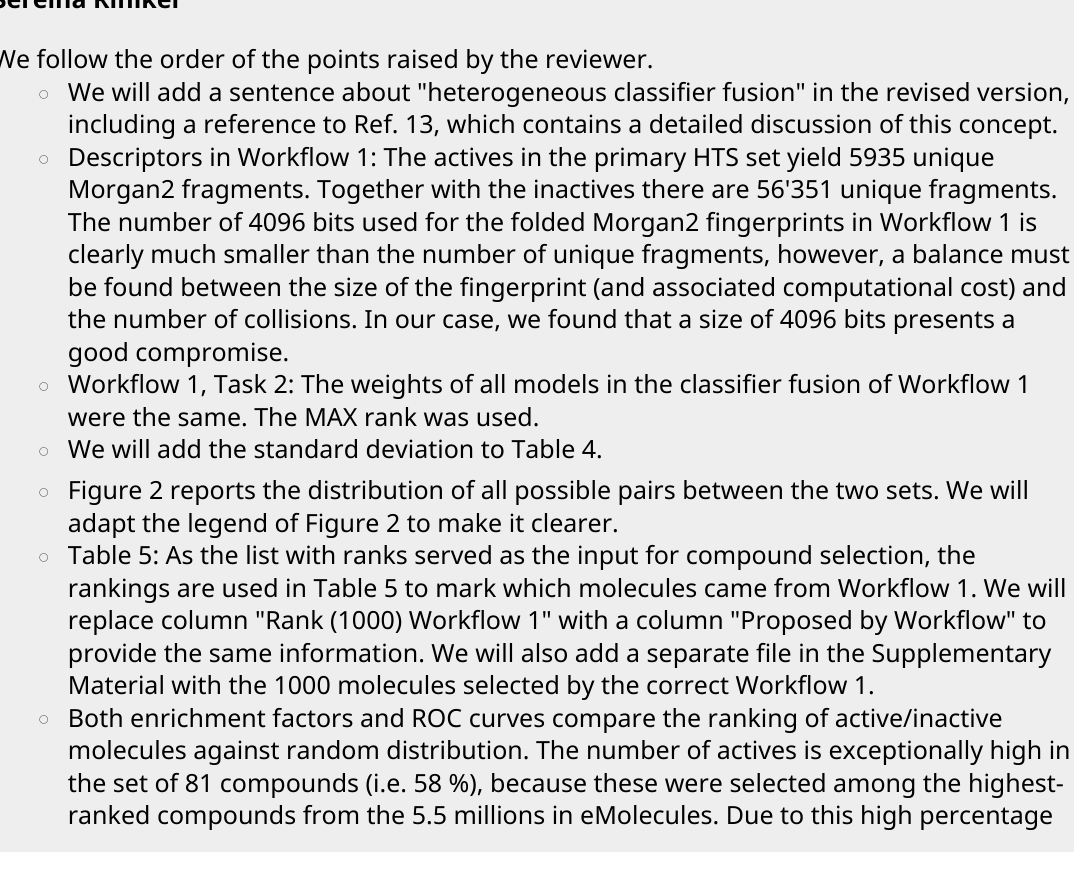
Table 5: As the list with ranks served as the input for compound selection, the rankings are used in Table 5 to mark which molecules came from Workflow 1. We